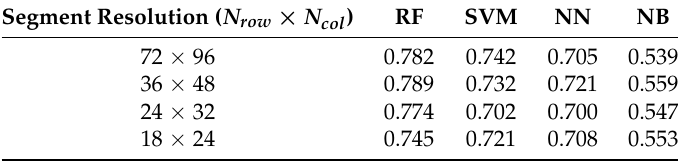
Table 5. F-measures for linkage line visibility classification.